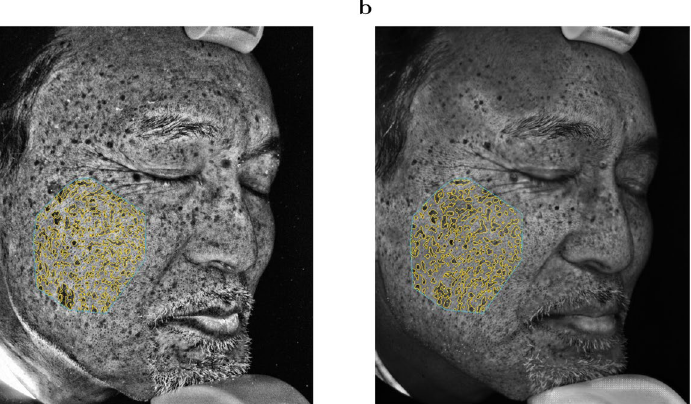
Figure 4. Detected pigment spots by Spot Net for ( a ) the UV photo image of a right profile face and ( b ) the corresponding synthetic UV image by UV-photo Net. The area surrounded by a blue line is a manually selected cheek region, and the areas surrounded by yellow lines denote the detected pigment